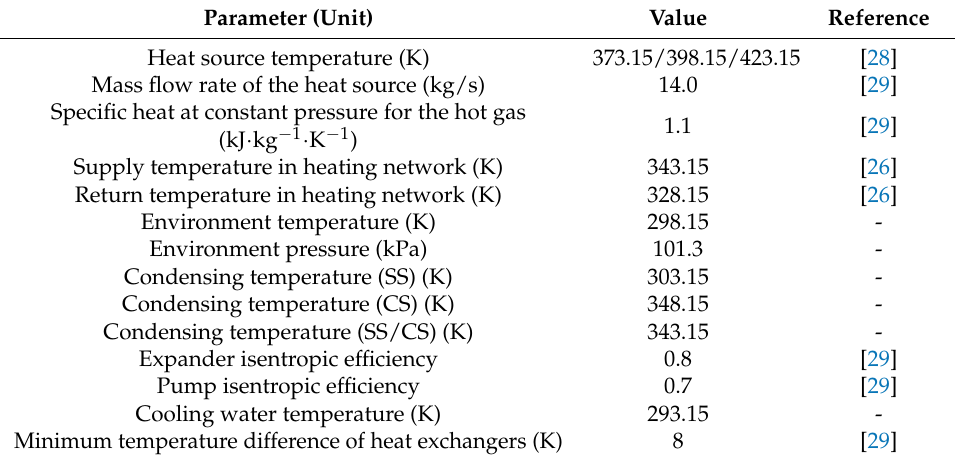
Table 1. The constant parameters assumed for system performance